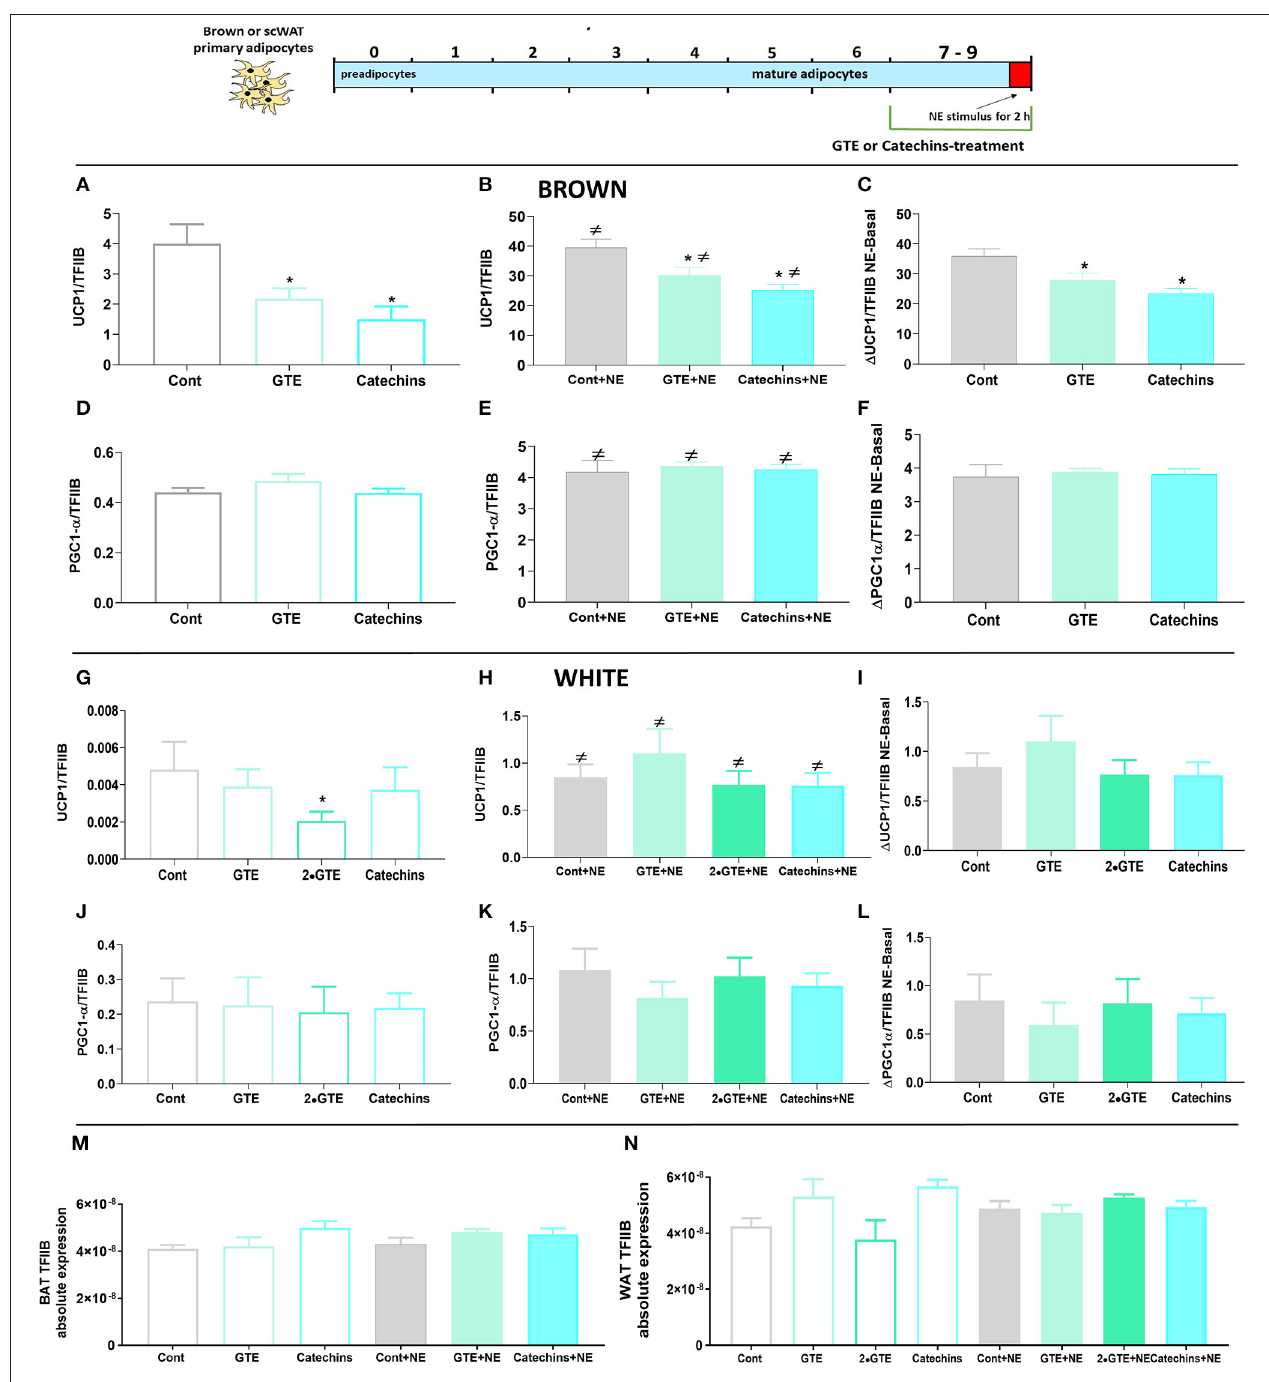
FIGURE 5 | Effect of green tea compounds on mature brown and white adipocytes. Brown and white adipocytes were grown in culture for 7 days and then treated with green tea compounds (as specified in Figure 1 ) for 2 days and finally stimulated with norepinephrine for 2h. Brown adipocyte Ucp1 mRNA levels in basal (A) and NE-stimulated states (B) and the norepinephrine-induced change (C) are shown. (D–F) results for Pgc1 α . (G–I) results for UCP1 in white adipocytes; (J–L) results for Pgc1 α in white adipocytes. Ucp1 and Pgc1 α mRNA levels were normalized to the TFIIB levels in each sample ( M TFIIB levels in brown and N in white adipocytes). The results are means ± SEM of five independent experiments, each performed in duplicate. Statistics are as in Figure 1 . differentiation process reduced the level of UCP1 mRNA of cells with rosiglitazone for 7 days increased the levels even in these cells ( Figure 6B ). The green tea compounds indeed of UCP1 about 10-fold ( Figure 6B ); however, the presence lowered the effect of rosiglitazone as such ( Figure 6C of the green tea compounds during the rosiglitazone